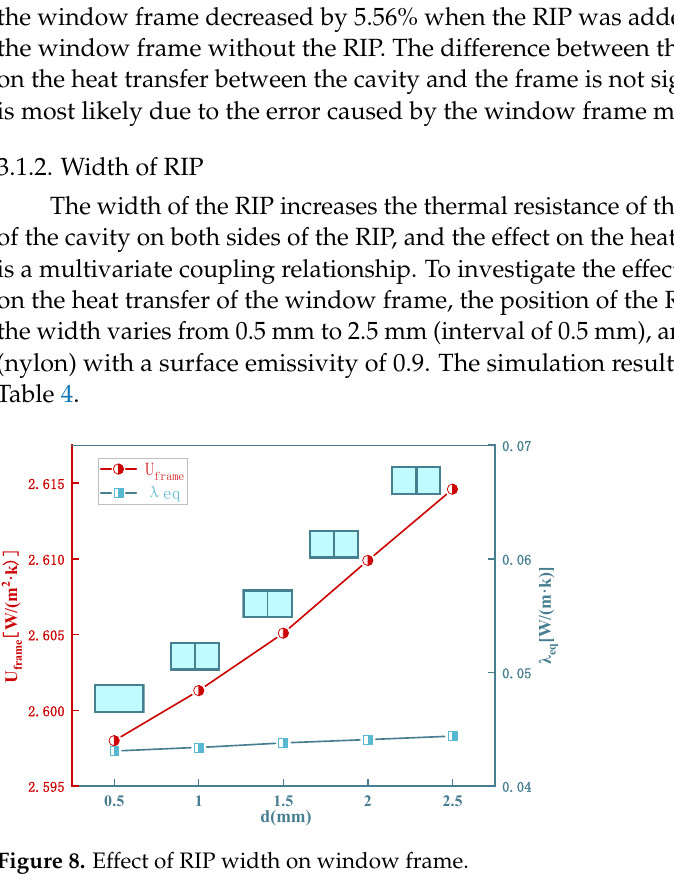
Table 3. Effect of RIP position on heat transfer from window frame.